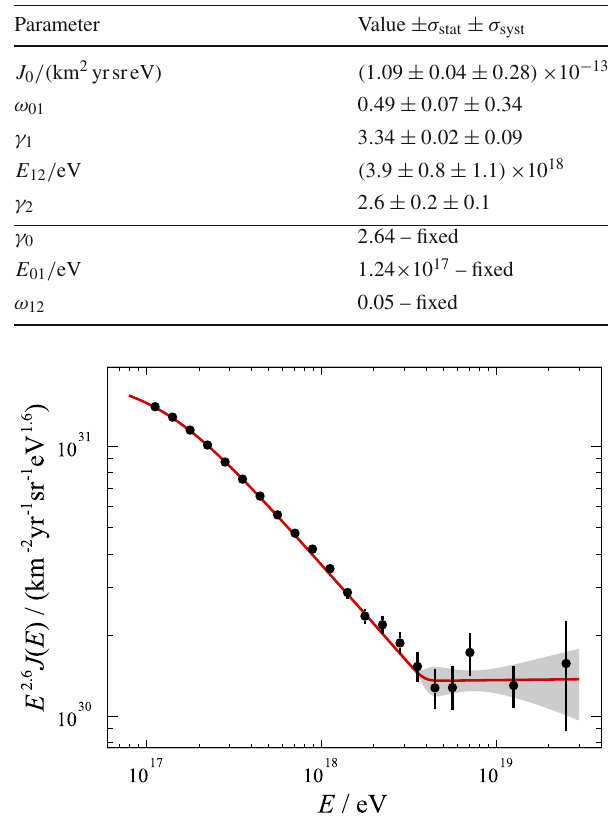
Table 6 Best-fit values of the spectral parameters (Eq. (11)). The parameter ω 12 is fixed to the value constrained in [21]. Note that the parameters γ 0 and E 01 correspond to features below the measured energy region and are treated only as aspects of the unfolding fixed to their best-fit values to infer the uncertainties of the measured spectral parameters